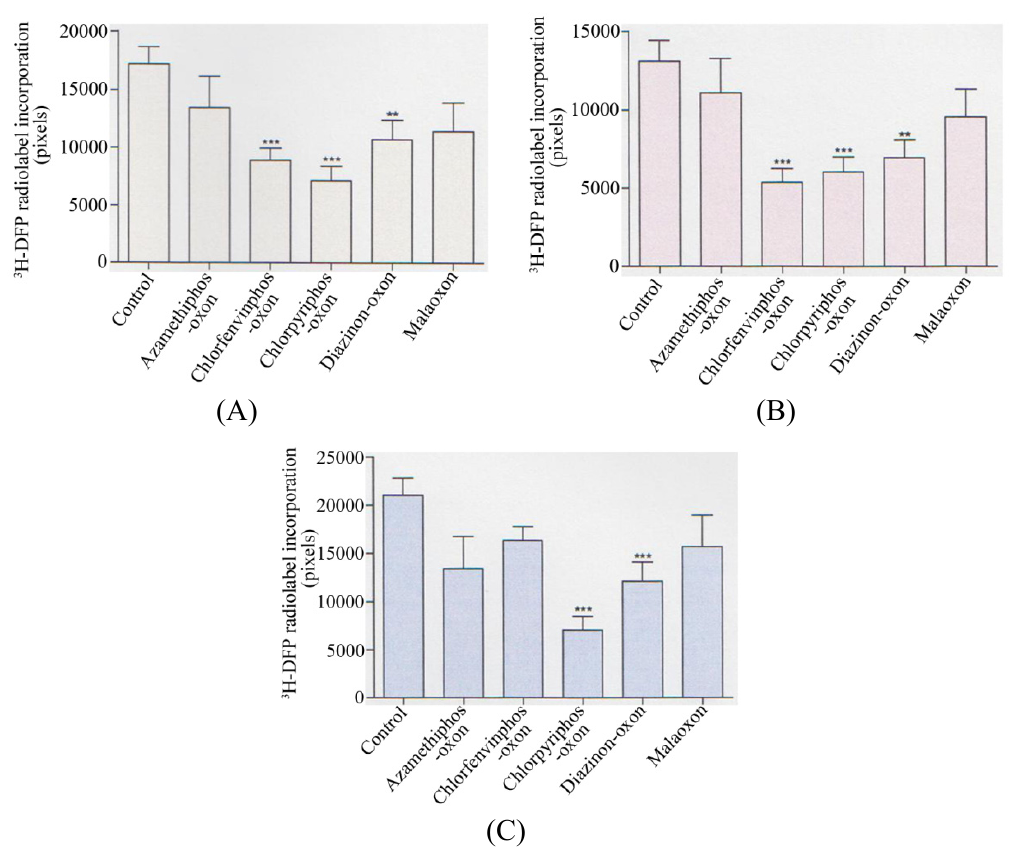
Figure 3. Summary of quantification of in vitro pesticide binding to protein targets in thymus